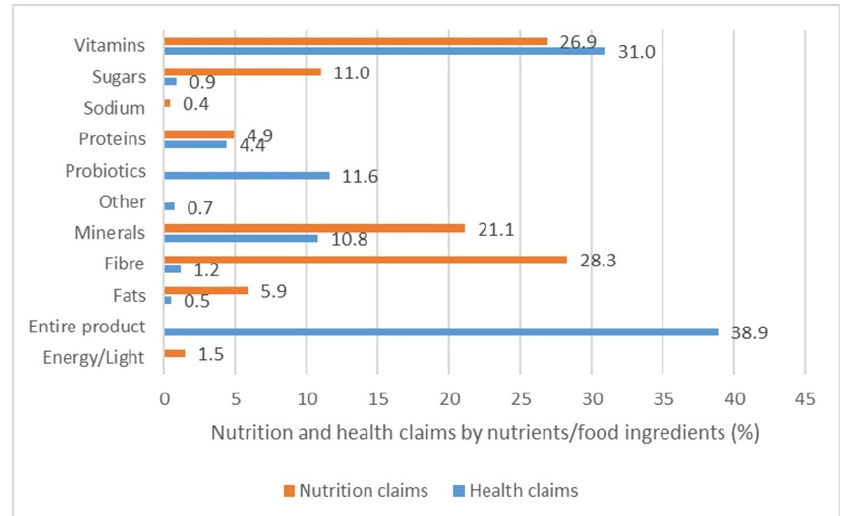
Figure 1. Proportion of nutrition and health claims for each nutrient/ingredient.